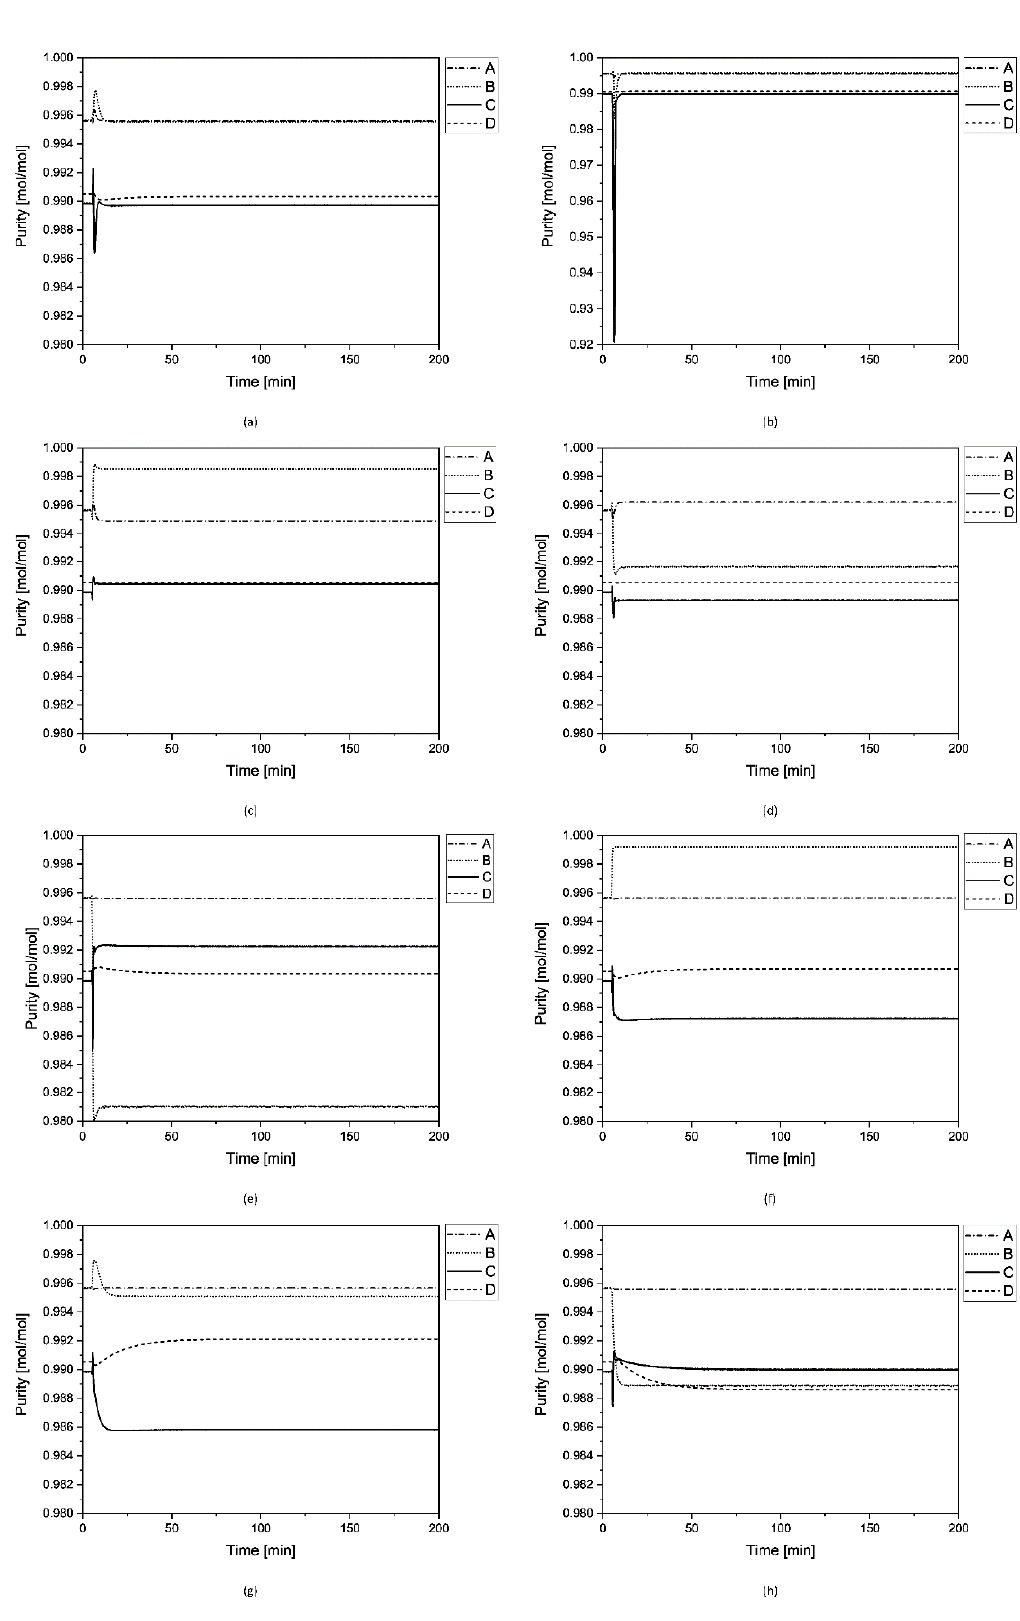
Figure 8. Simulated dynamic results on product qualities for mixture 1 for different disturbances: ( a ) scenario 1, ( b ) scenario 2, ( c ) scenario 3, ( d ) scenario 4, ( e ) scenario 5, ( f ) scenario 6, ( g ) scenario 7, and ( h ) scenario 8.